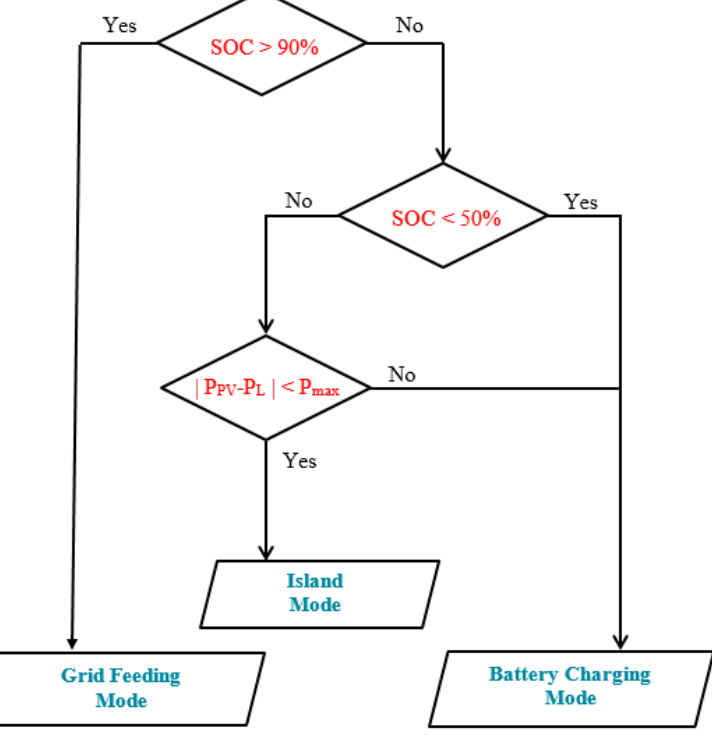
Figure 6. Rule-based EMS flowchart.